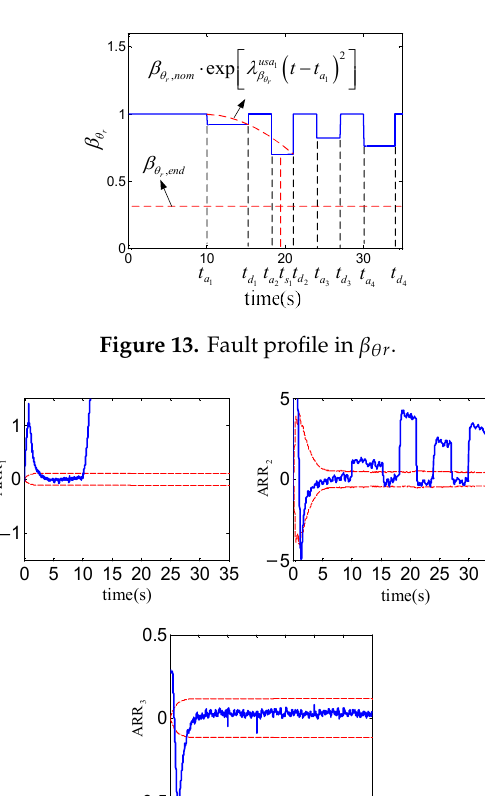
r  Figure 12. 𝛽 (cid:3087)(cid:3045) RUL prediction results. In the second experiment, an abrupt fault in rv R and a non-monotonic intermittent fault in